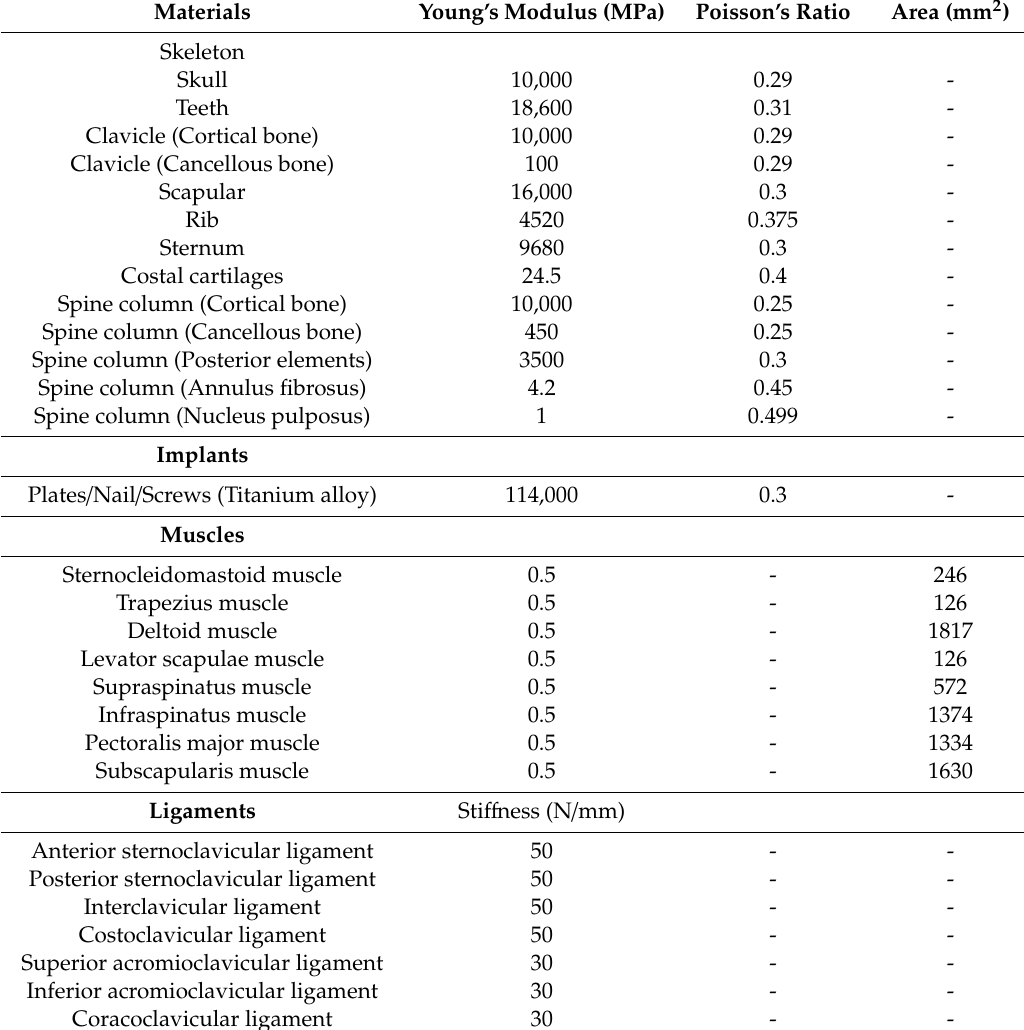
Table 1. Material properties of the numerical